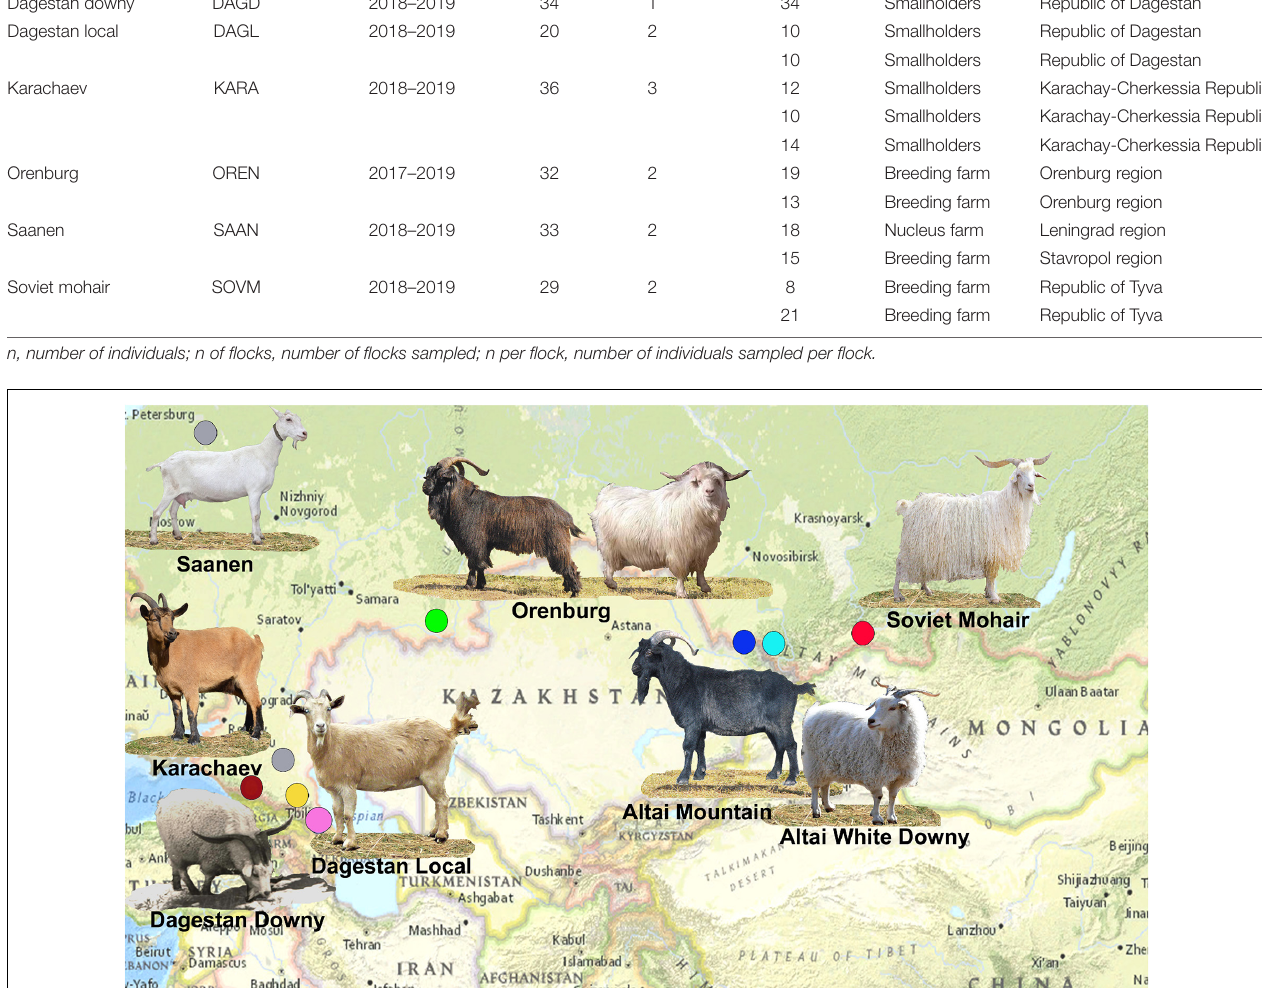
minor allele frequency (MAF) lower than 5% (–maf 0.05), and those located on sex chromosomes and with unknown